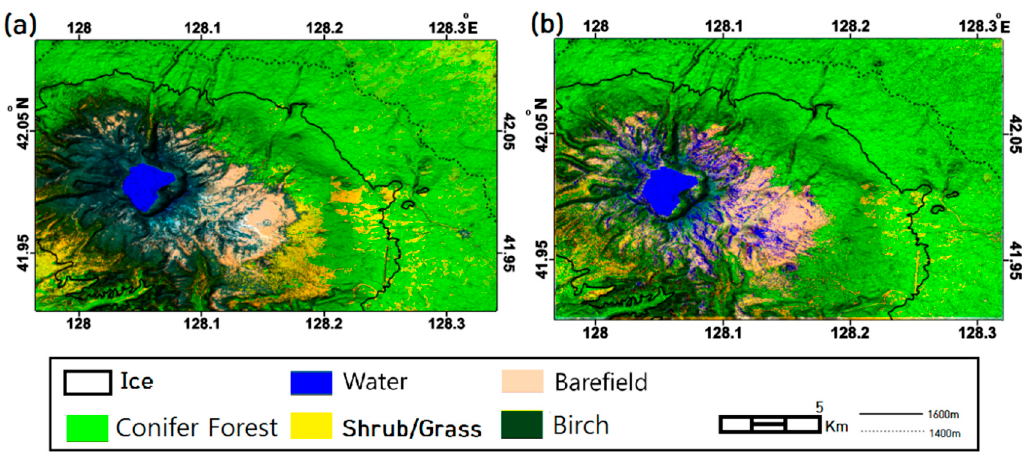
Figure 8. The detailed land cover classifications over Mt. Baekdu from EO-1 ALi optical image SVM processing ( a ) and HH1 packet with k-PCA plus SVM analysis ( b ).